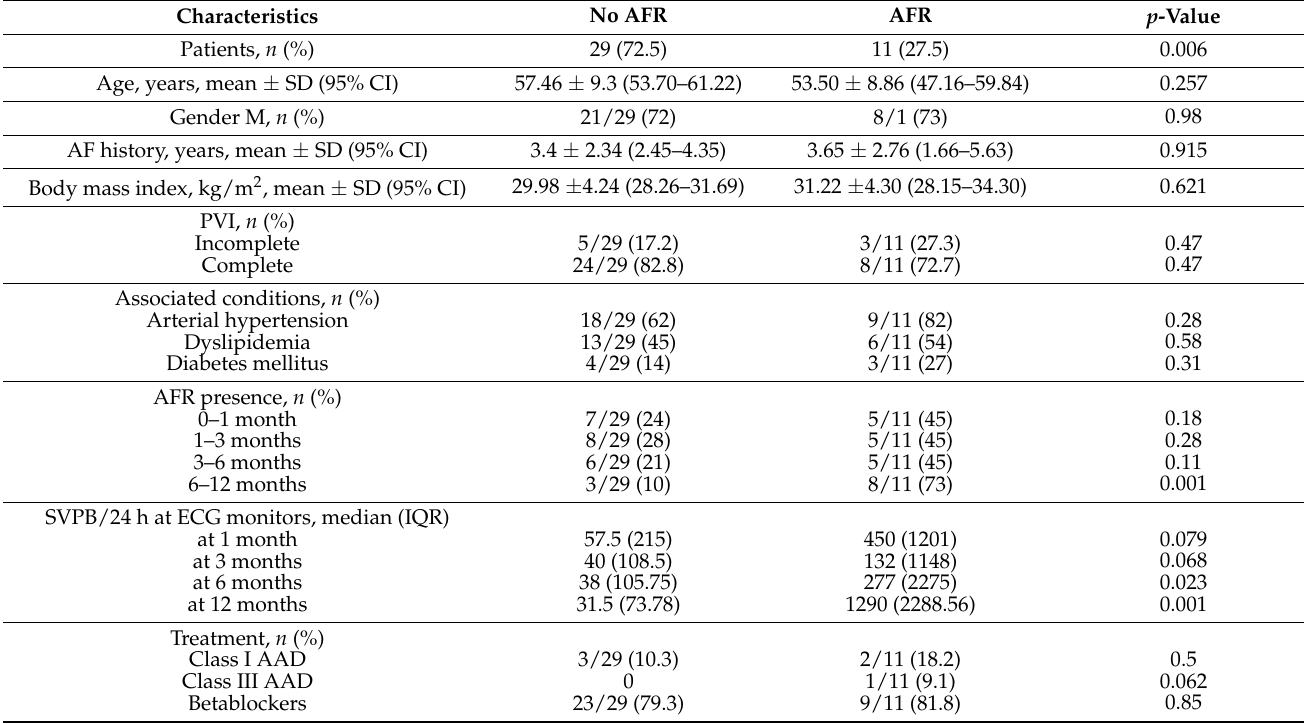
Table 4. Characteristics for patients with and without AFR after 12